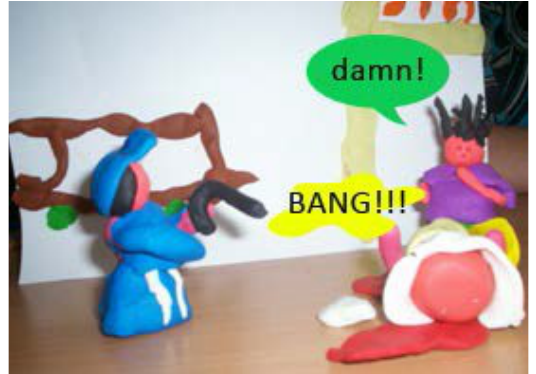
Figure 1. The game interface